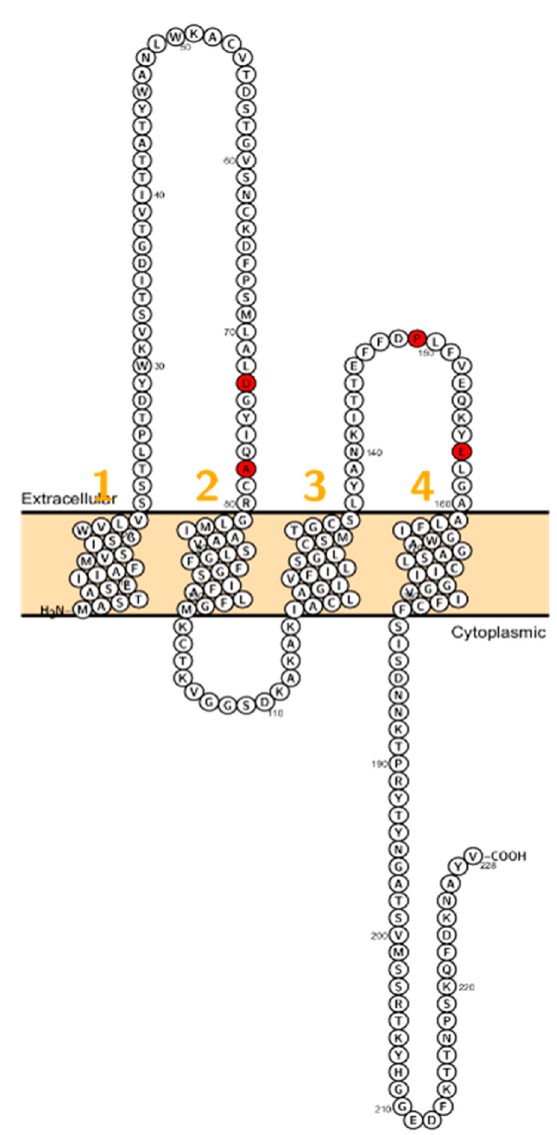
Figure 4. Topology of CLDN10 . FASTA sequence of CLDN10 (Uniprot accession no: P78369). Each amino acid is shown as a single letter code and numbers (orange) indicate transmembrane domains. Mutations shown to be involved in human diseases are shown in red.